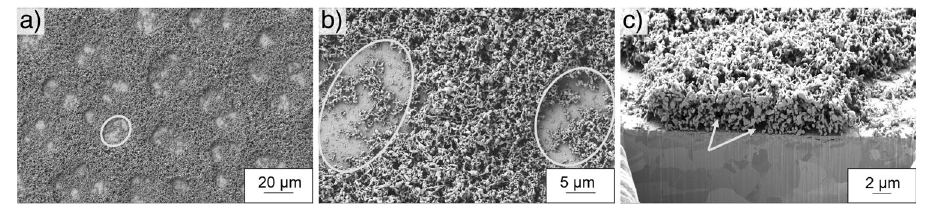
Fig. 4 SEM and FIB-SEM images taken from a porous foam model electrode (electrochemically deposited with 2.0 Acm − 2 for 5 s). The images show an overview of the macro-porous region ( a ) and the transition from macro-porous craters to nano-porous foam walls ( b ) and ( c ).